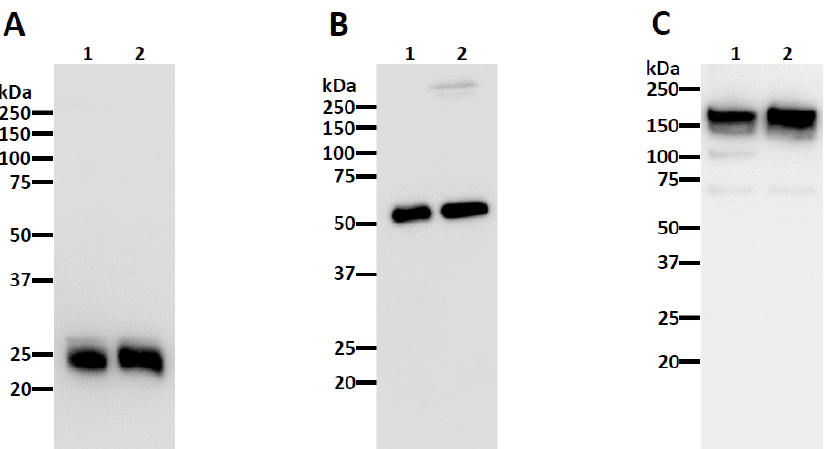
Figure 2. Western blot analysis of plant-made CA1. Plant-made CA1 was subjected to SDS-PAGE under reducing conditions ( A , B ) and non-reducing conditions ( C ). Proteins were transferred to a PVDF membrane after separation and a horseradish peroxidase-conjugated goat anti-human kappa ( A , C ) or goat anti-human IgG ( B ) antibody was used to detect the light chain and heavy chain, respectively. Lane 1, plant-made CA1; Lane 2, mammalian cell-produced anti-West Nile virus E protein (E16) IgG. The blots are representatives of multiple independent experiments.